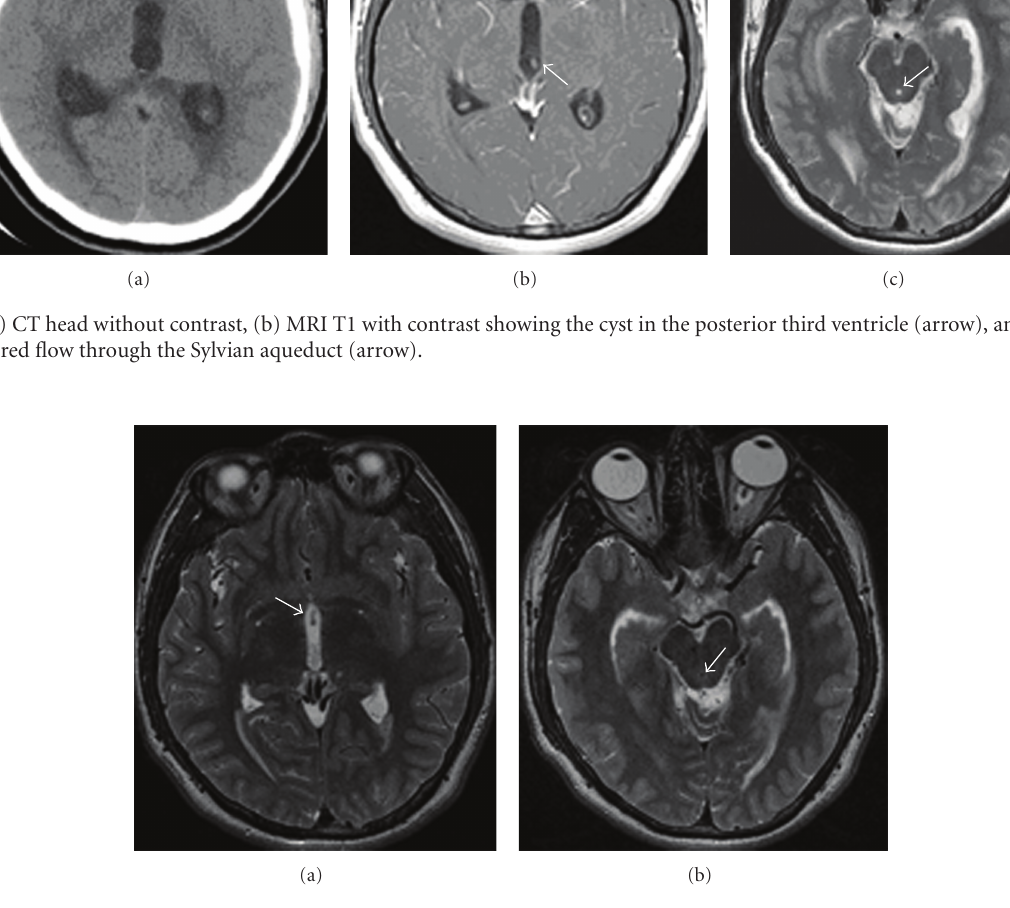
Figure 2: (a) MRI T2 showing migration of the cyst to the anterior third ventricle (arrow) and (b) MRI T2 demonstrating a flow void in the Sylvian aqueduct consistent with restoration of CSF flow (arrow). Of note, reduction in the size of the temporal horns is also